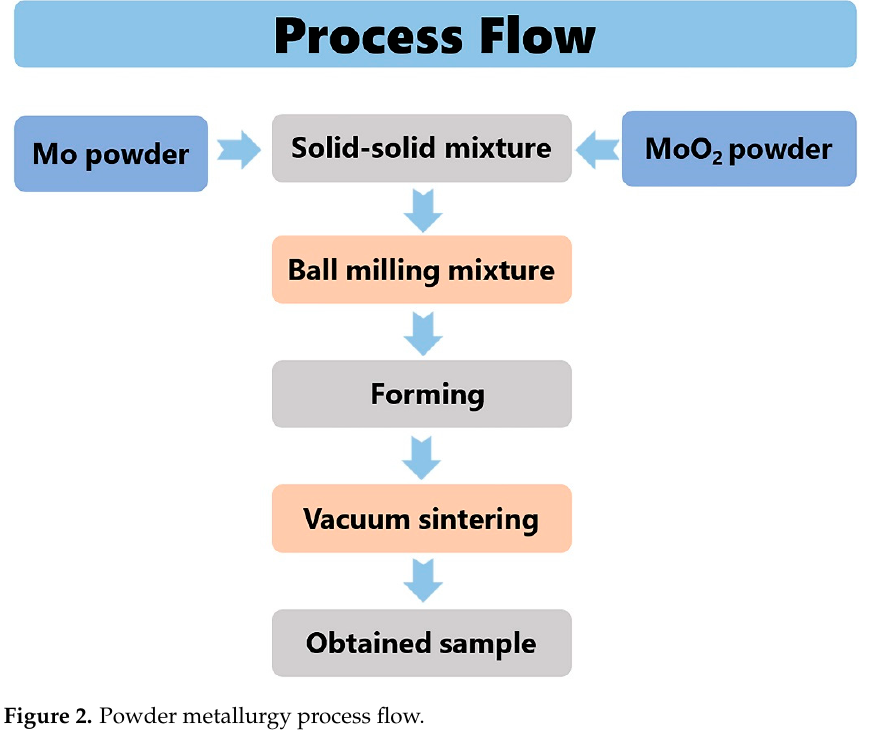
Figure 2. Powder metallurgy process flow.